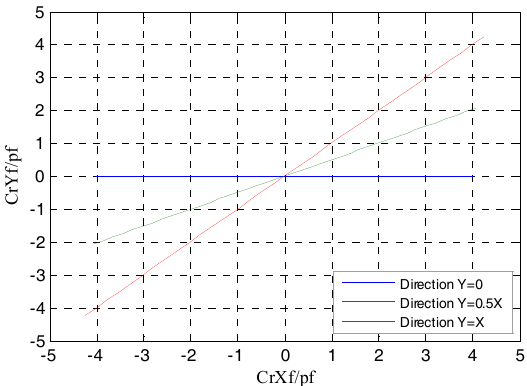
Figure 13. CrYf/CrXf in the different radial runout directions.